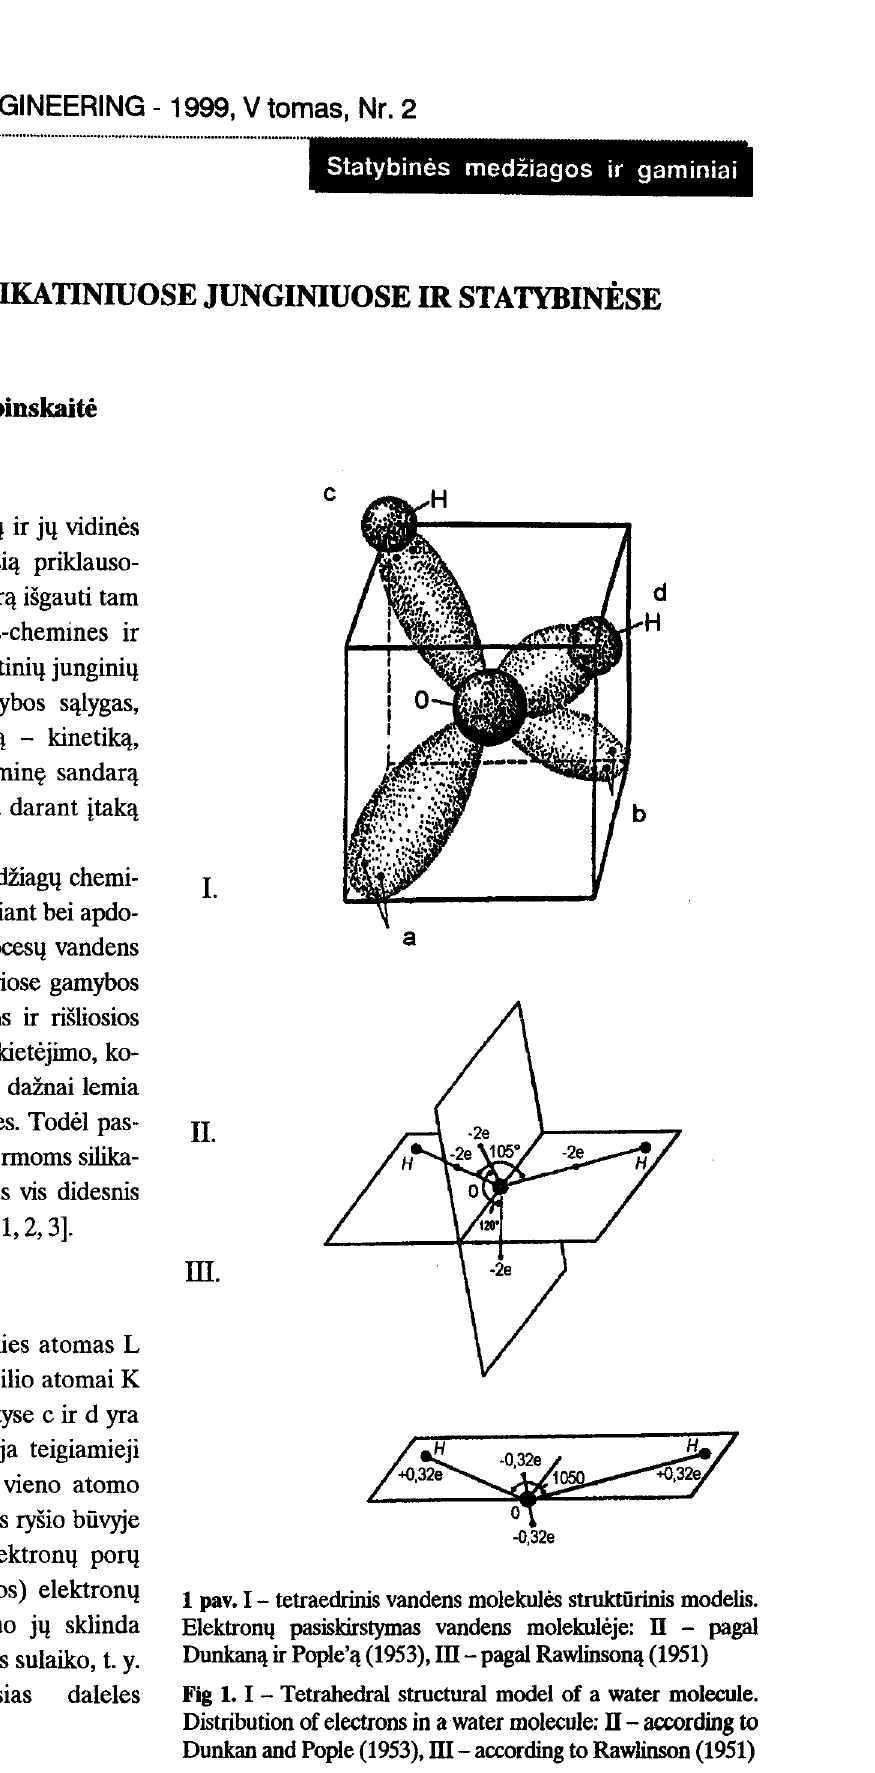
pritraukia prisiartinancias teigiam'lsias daleles (1 pav.).